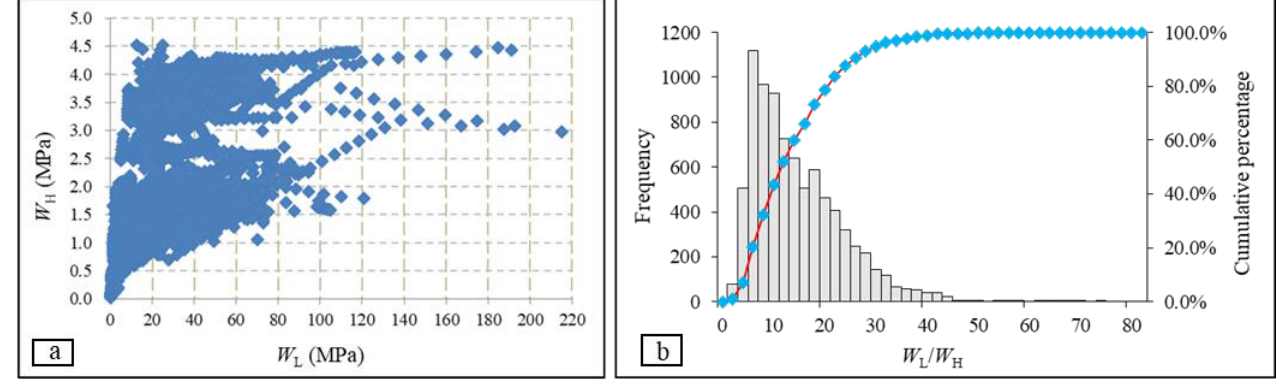
Figure 6. W H - W L scatter plot and W H / W L ratio cumulative frequency curve of intrusive rock buried- hill in the Y area (includes 6 wells and 8309 datapoints). ( a ) W H - W L scatter plot; ( b ) W H / W L ratio cumulative frequency curve.